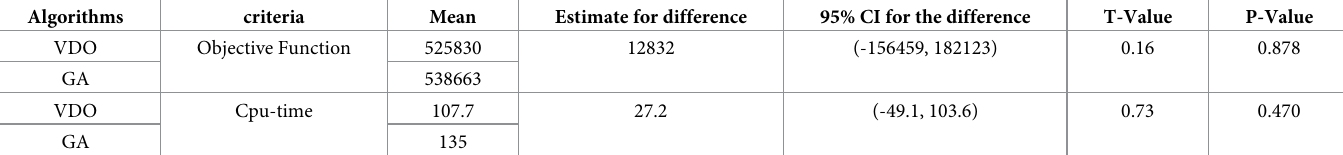
Table 12. The results of T-test for the significance testing of the differences between the considered criteria in solving large-sized problems. Algorithms